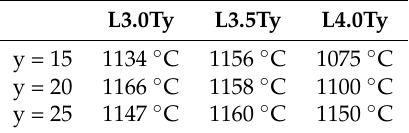
Table 1. Temperature of maximum shrinkage rate (minimum in the derivatives) for each LKNNT composition